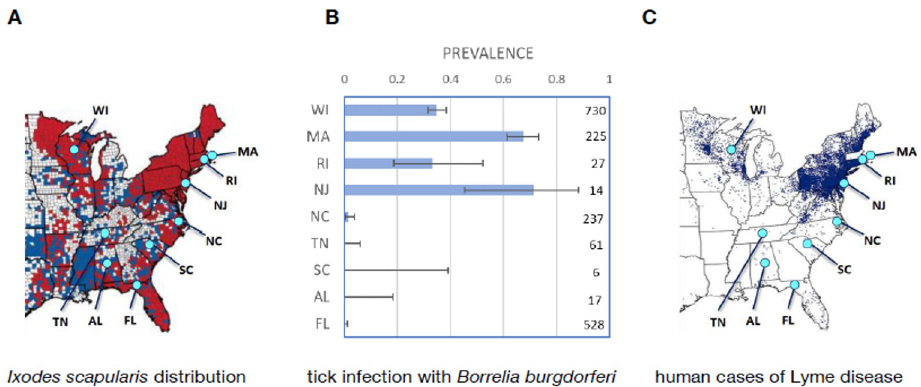
Fig 1. Locations of study sites and tick infection prevalence. ( A ) Map of distribution of Ixodes scapularis ticks; red counties have tick populations that are considered established (at least 6 ticks or at least 2 of the host-seeking life stages had been identified in a single collection period), and blue counties have at least some tick collections, but establishment has not been demonstrated [2]. ( B ) Infection prevalence in host-seeking adult I . scapularis with binomial 95% confidence intervals (from current study; number to the right of each bar is the number of ticks tested to provide that infection prevalence value). ( C ) Map of human cases of Lyme disease in the eastern and central US in 2018 (CDC map; each dot indicates 1 case of Lyme disease, placed randomly in the patient’s county of residence; https://www.cdc. gov/lyme/stats/maps.html). Maps in Fig 1A and 1C are from the CDC, and data in Fig 1B are available in S1 Data. CDC, Centers for Disease Control and